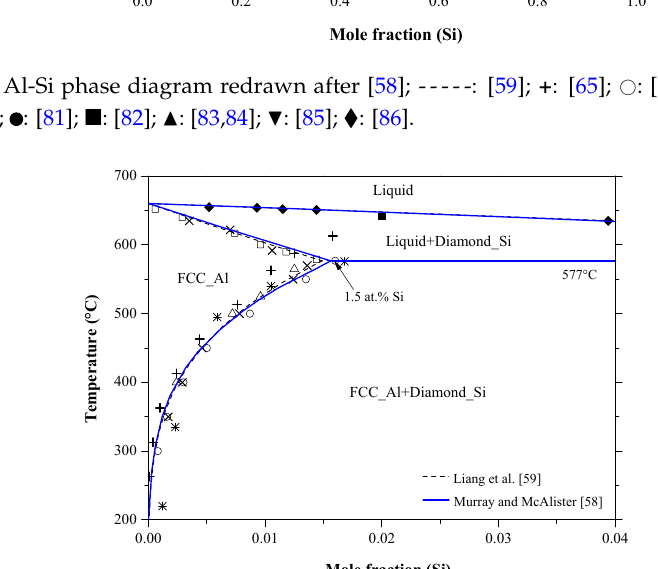
Figure 4. Al-rich side of the Al-Si phase diagram [58]; ----: [59]; ×: [60]; *: [61]; ○ : [62]; □ : [63]; Δ : [64]; +: [65].